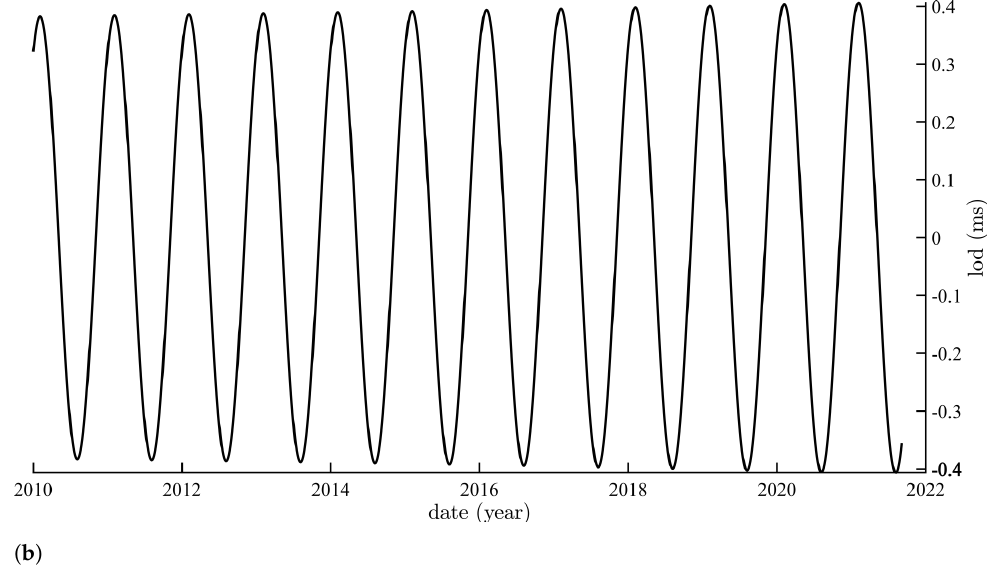
Figure 5. Annual and semi-annual components extracted from lod and PM: ( a ) superimposition of the SSA annual components of the m 2 and lod time series ( top : 1978–2022; bottom : enlargement of 2010–2022); ( b ) SSA semi-annual component of the lod time series (2010–2022).